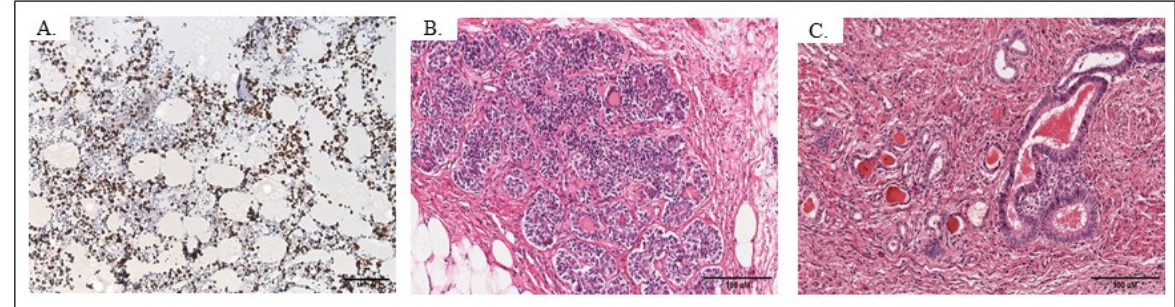
Figure 3. HE staining of the strumal carcinoid of the ovary, objective magn. × 20, Leica DM5000B, Wetzlar, Germany. Ki-67 expression was limited to the bone marrow area of the teratoma ( A ); rounded or arched cords of columnar or pyramidal cells typical for the glomerulosa zone of the adrenal cortex were visible within the strumal carcinoid ( B ); thyrocytes with variability in shape—cuboidal, flattened or even slightly columnar—were observed surrounding the colloid ( C ).